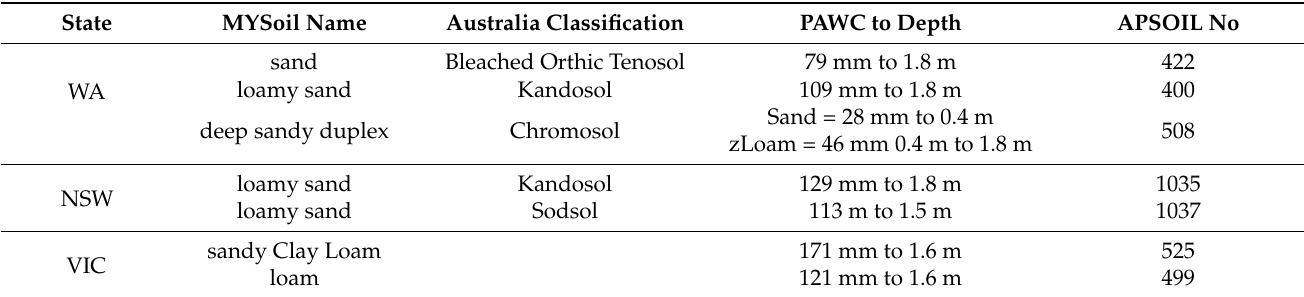
Table 2. Soil used in the APSIM simulations for each state with their Australian classification, PAWC and APSOIL number.